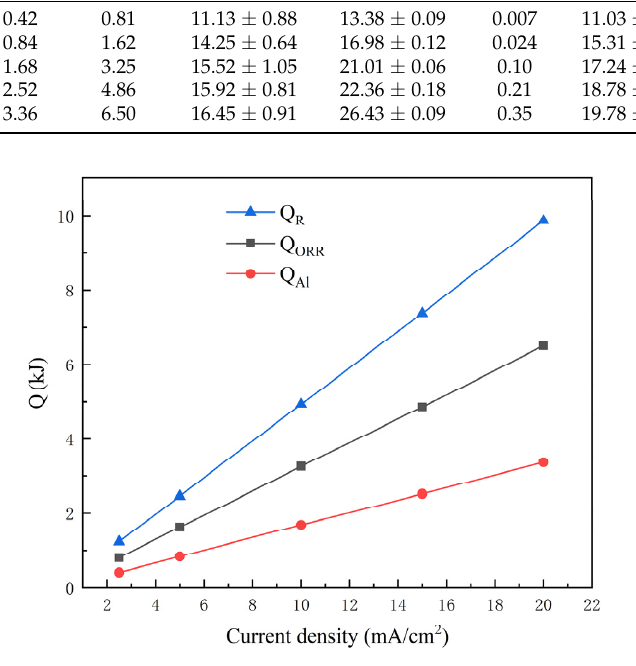
Figure 4. Calculation results for Q Al , Q ORR , and Q R with different discharge current densities. Q int was introduced to directly characterize the sum of Q J and Q P . The internal resistance ( R int ) of the battery was measured at different discharge densities, as shown in Figure 5a, and the corresponding values of Q int are exhibited in Figure 5b. It can be observed that R int increased slightly (from 0.35 and 0.4) with current density, exhibiting little change with discharge time. Therefore, the values of Q int calculated by Equation (25) are mainly determined by discharge current density.